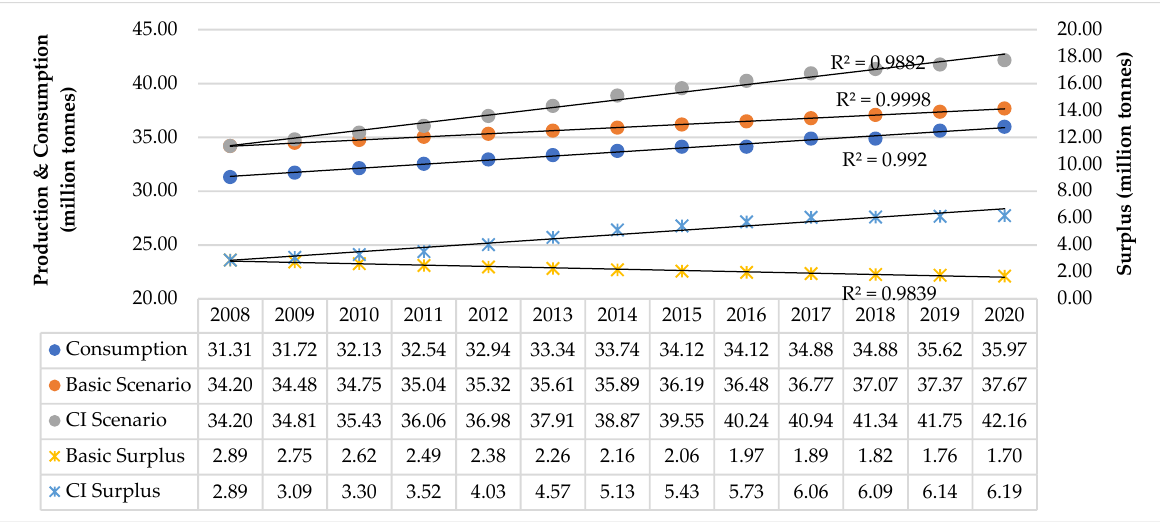
Figure 3. The scenarios of consumption needs, CI, and surplus application of rice self-sufficiency in Indonesia (2008–2020). Note: Consumption = number of populations × per capita rice need; Cropping index (CI) scenario = production × harvested area; Basic surplus = production of CI scenario subtracted by consumption; CI surplus = production subtracted by consumption.